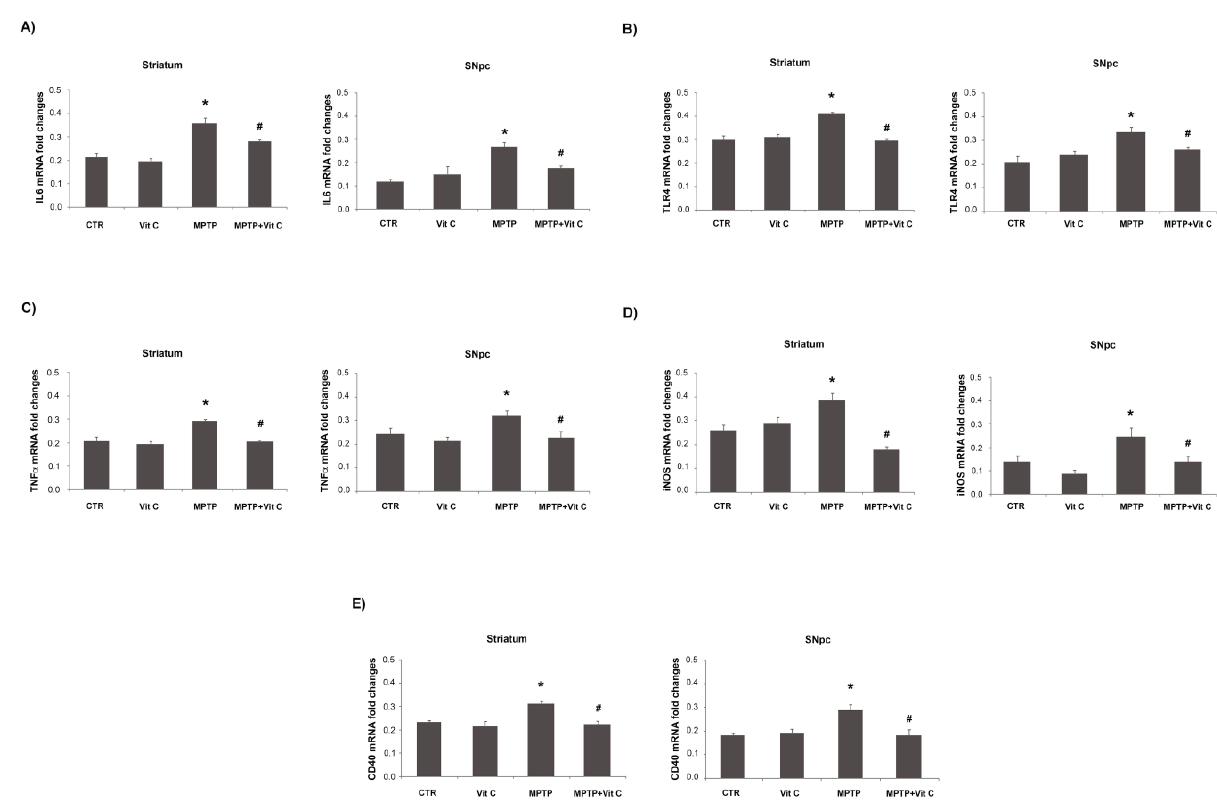
Figure 7. Effects of Vit C on the expression of pro-inflammatory markers in MPTP-treated mice. Real-time PCR analysis of ( A ) IL-6, ( B ) TLR4, ( C ) TNF- α , ( D ) iNOS, and ( E ) CD40 mRNA expression levels in controls (CTR), mice treated with Vitamin C (VIT C), MPTP, MPTP, and Vitamin C (MPTP+ VIT C) in striatum ( left ) and SNpc ( right ). Results are presented as mRNA fold changes relative to GAPDH, used as resident control. Data are presented as mean ± SD (* p < 0.05 vs. CTR; # p < 0.05 vs. MPTP).